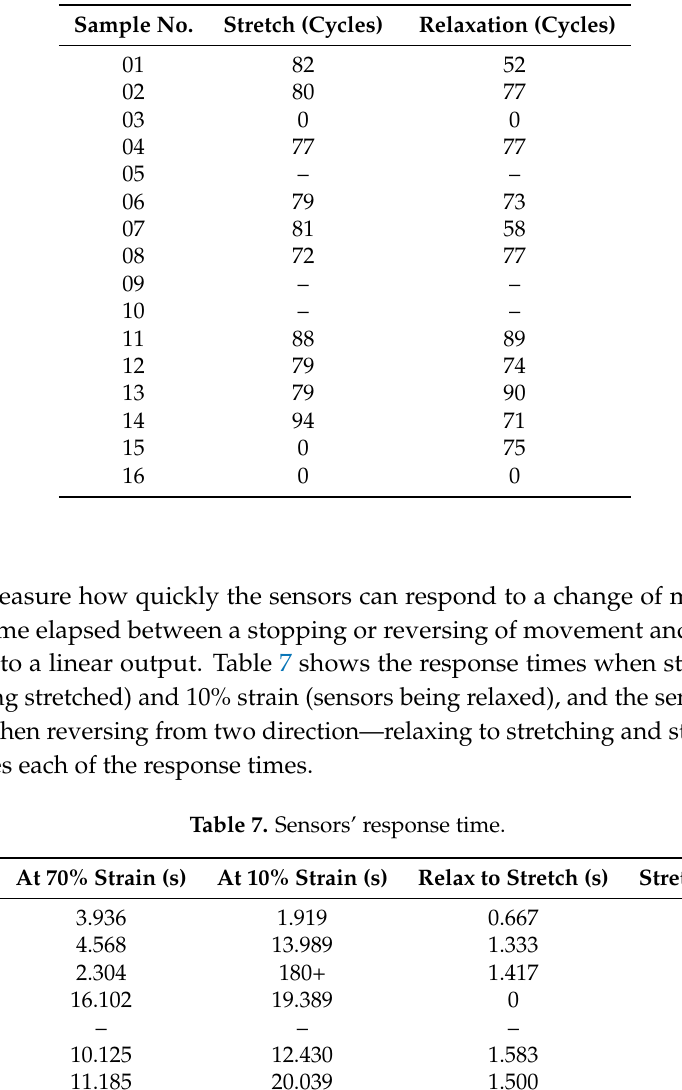
Figure 11. The error between each cycle of stretching and the fitted line of Sample 07. This plot shows a relatively worse repeatability result from all the samples‘ stretch and relax. Table 6. The cycle number at which sensors showed signs of fatigue.